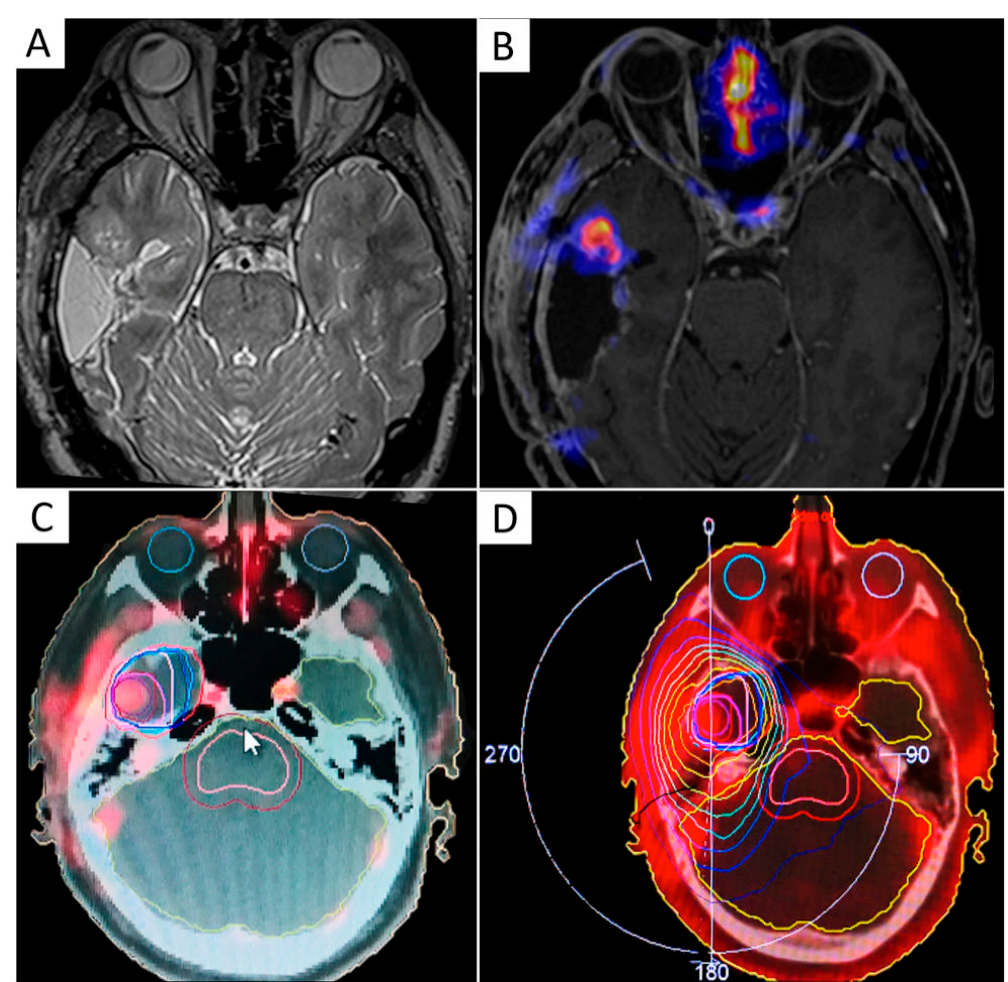
Figure 4. Example of a volumetric modulated arc therapy (VMAT) sequential boost of radiation to hypoxia-positive recurrent GBM. T2-weighted and contrast-enhanced T1-weighted MRI sequences were acquired along with 64 Cu-diacetyl- bis(N 4 -methylthiosemicarbazone) (ATSM) PET on a hybrid 3T PET/MR scanner, three hours after radiopharmaceutical injection ( A , B ). 37.5 Gy were delivered in 15 daily fractions to the surgical cavity followed by a boost of radiation (5 Gy) to the 64 Cu-ATSM-positive tumor region, indicating chronic hypoxia ( C , D ).